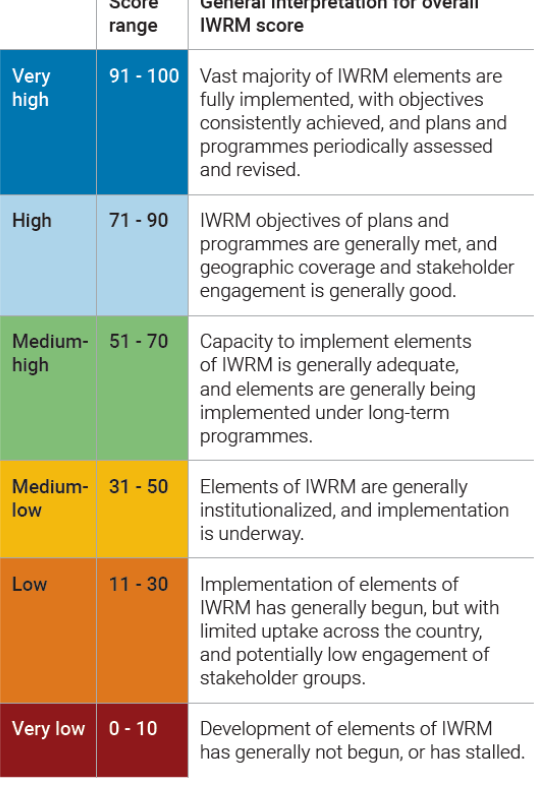
Figure 4. Overall IWRM implementation categories and their interpretation based on average scores [36].